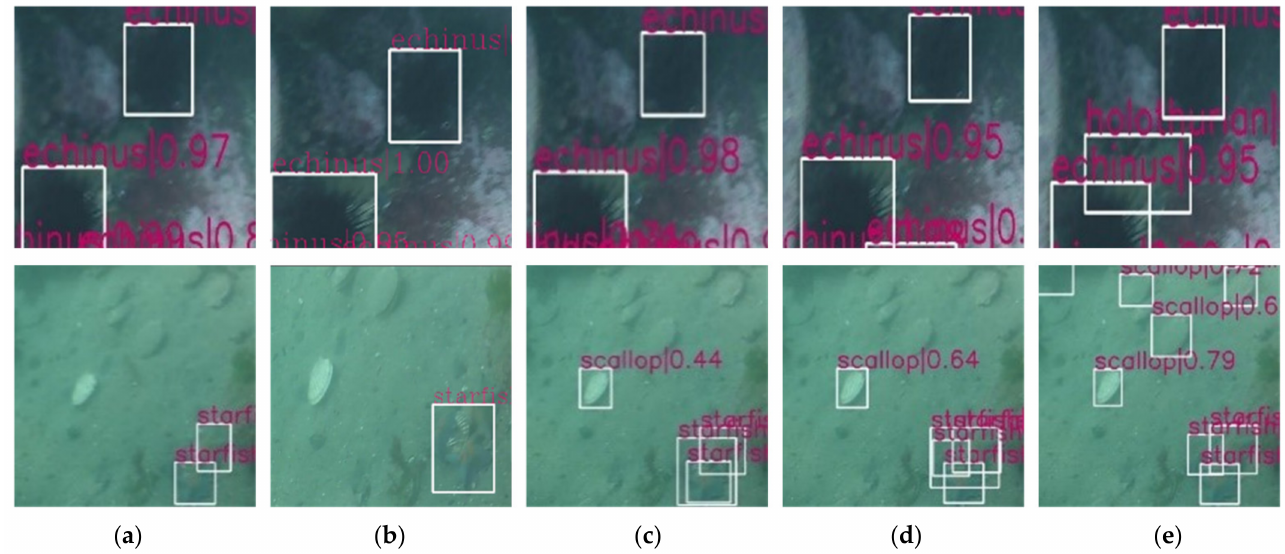
Figure 9. Comparison results of different model detections: ( a ) SSD, ( b ) Yolo_v3, ( c ) Faster RCNN, ( d ) Cascade RCNN ( e ) proposed